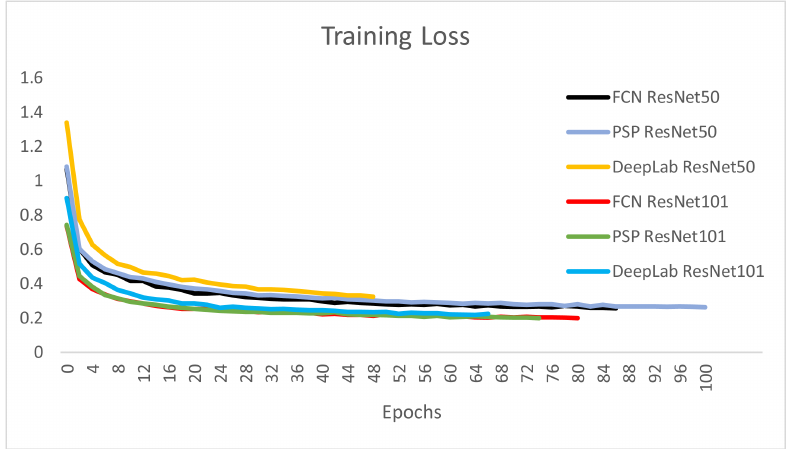
Figure 8. Training Loss: the best losses are obtained by the 3 architectures based on the ResNet101 encoder. Figure 9 and Table 1 show the overall validation accuracy for the networks presented.